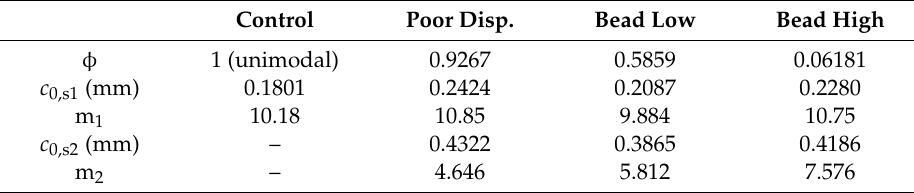
Table 4. Weibull Fitting Parameters for c 0